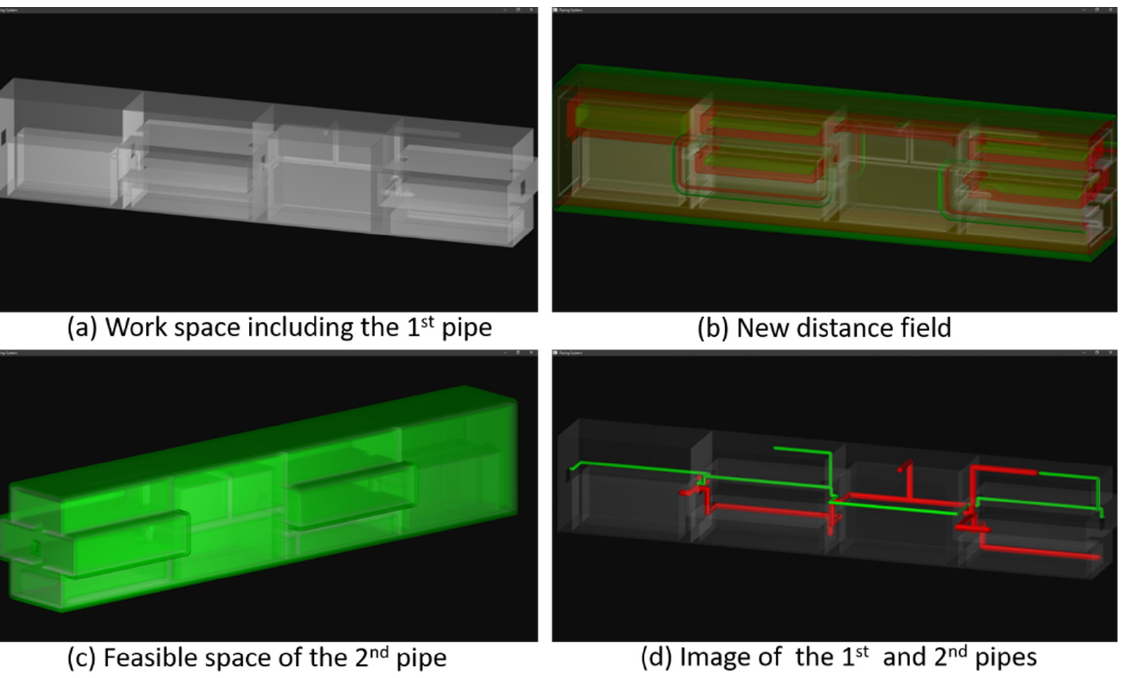
Figure 5. Routing the 2nd pipe, ( a ) the modified workspace, ( b ) two layers in the new distance field, shaded in green and red colors, ( c ) the feasible space of the 2nd pipe, and ( d ) the results, including the 1st and 2nd pipes (in red and green colors).